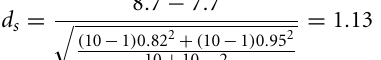
Table 3 | Artificial movie